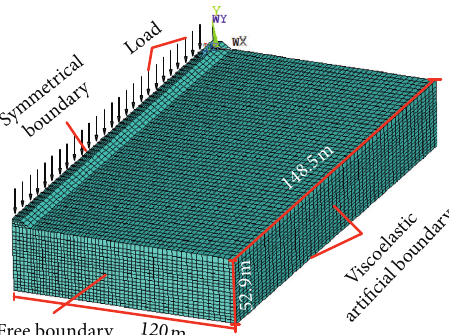
Figure 3: Three-dimensional finite element model of site soil.